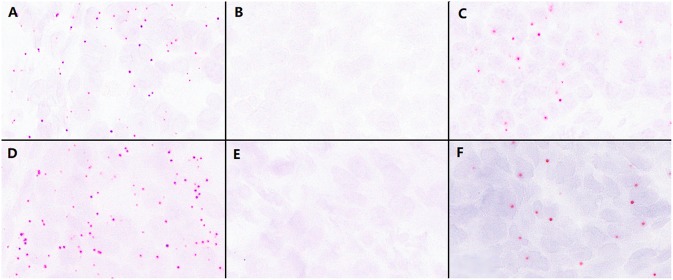
Validation of the effectiveness of the BaseScope probe in tumor tissues. (A) The analysis of RNA quality by the P286R positive control probes in P286R mutated high-grade endometrioid carcinoma (EC), showing a large number of positive signals. (B) Negative control probes showed no positive signal in P286R mutated EC. (C) The detection of P286R mutations in high-grade EC by BaseScope in situ hybridization, showing multiple strong red signals in the cytoplasm. (D) The analysis of RNA quality by V411L positive control probes in V411L mutated high-grade EC, showing a large number of positive signals. (E) Negative control probes showed no positive signal in V411L mutated EC. (F) The detection of V411L mutation in high-grade EC by BaseScope in situ hybridization, showing multiple strong red signals in the cytoplasm; Scale bars represent 60 microns.